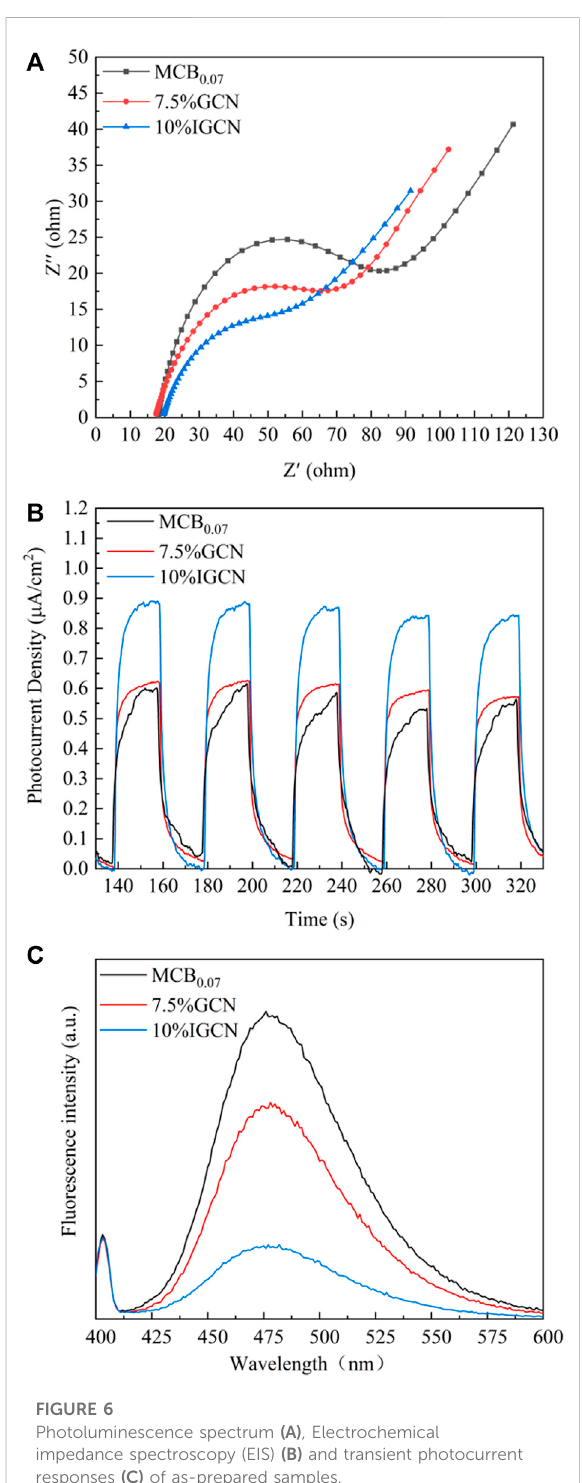
FIGURE 6 Photoluminescence spectrum (A) , Electrochemical impedance spectroscopy (EIS) (B) and transient photocurrent responses (C) of as-prepared samples.